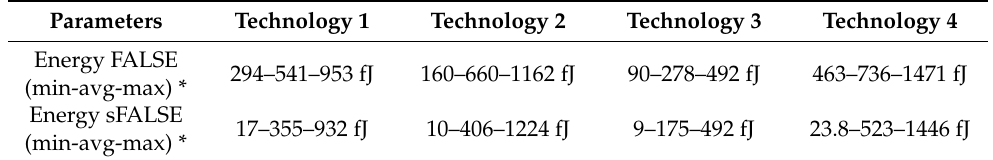
Figure 6. SIMPLY crossbar implementation. More than one comparator can be used to increase the computation parallelism.